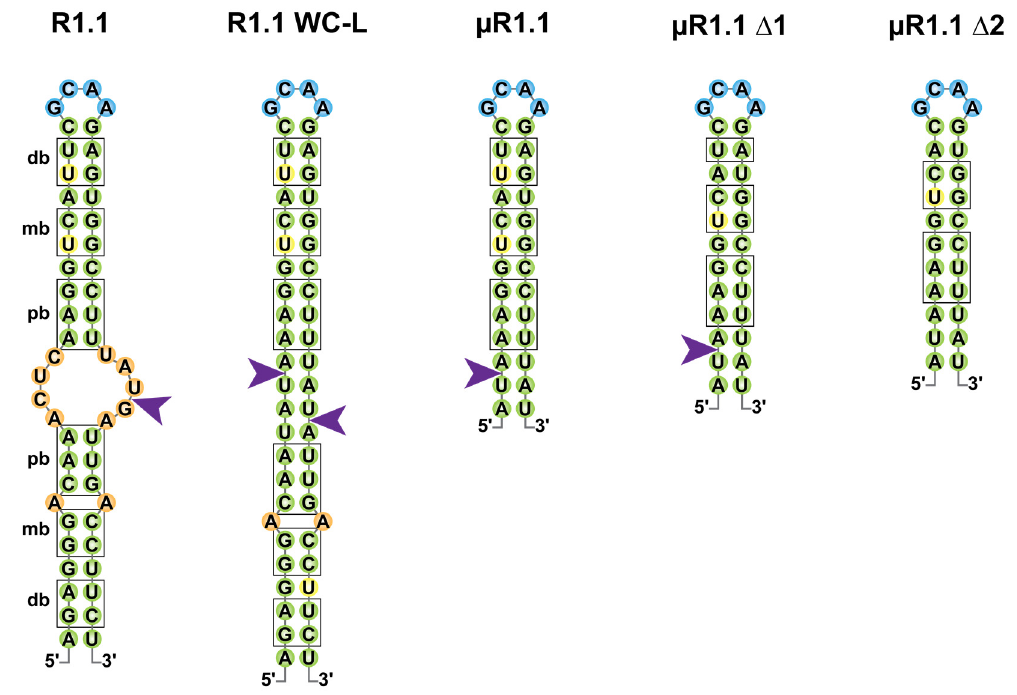
Figure 2. Cleavage of the T7 R1.1 RNA and its derivatives by Ec-RNase III. Secondary structures of RNase III target R1.1 RNA from the T7 phage and its artificial derivatives (R1.1 WC-L, µR1.1, µR1.1 Δ 1 and µR1.1 Δ 2) are represented in two dimensions as in [29,48]. Base pairs are represented in green; bulges and mismatches are represented in orange, loops in blue and uridine residues involved in wobble G-U base pairing in yellow. Proximal (pb), middle (mb) and distal (db) boxes are shown outlined in black and RNase III single-strand cleavage sites are represented by a purple arrow.